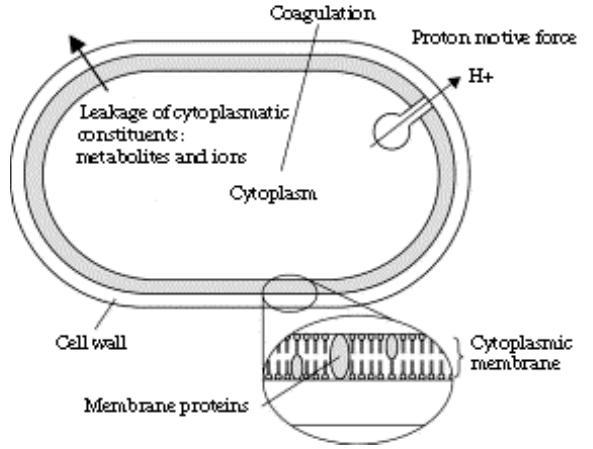
Figure 2. Sites in a bacterium where natural compounds are active